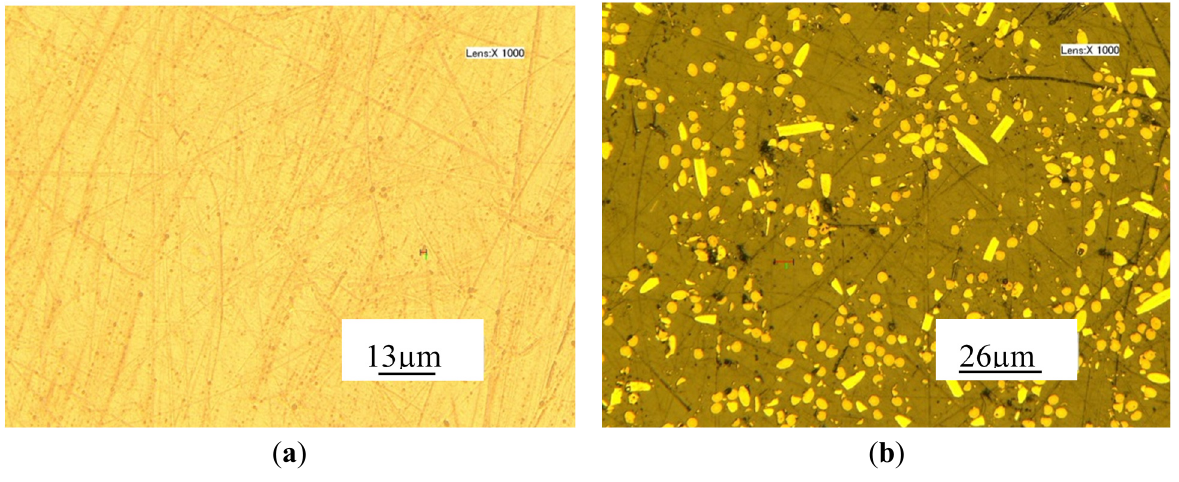
Figure 6. Material surface magnified a thousand times ( a ) PEEK; ( b ) PEEK CF